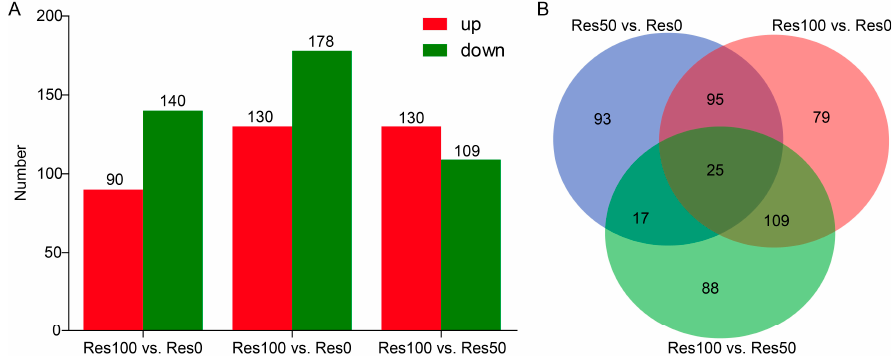
Figure 5. Differentially expressed gene (DEG) analysis. ( A ) Number of upregulated and downregulated DEGs between resveratrol-treated and control groups. ( B ) Venn analysis between resveratrol-treated and control groups.